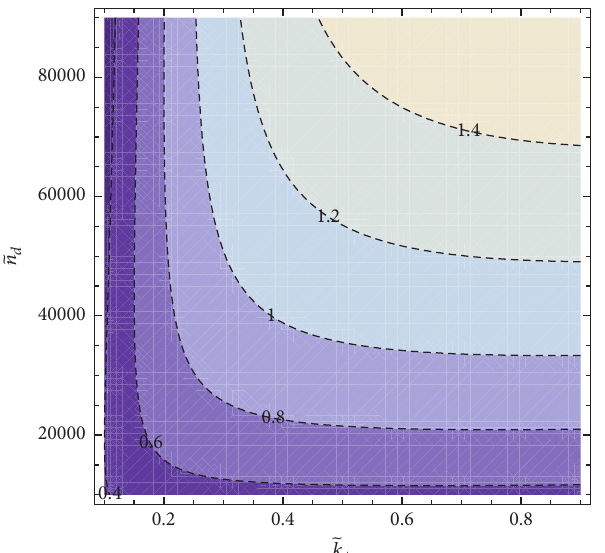
̃𝑘 and 𝑛 𝑑 for 𝑉 0 = 10 , 𝐶 𝑄 = 10 , and 𝑍 𝑑 =